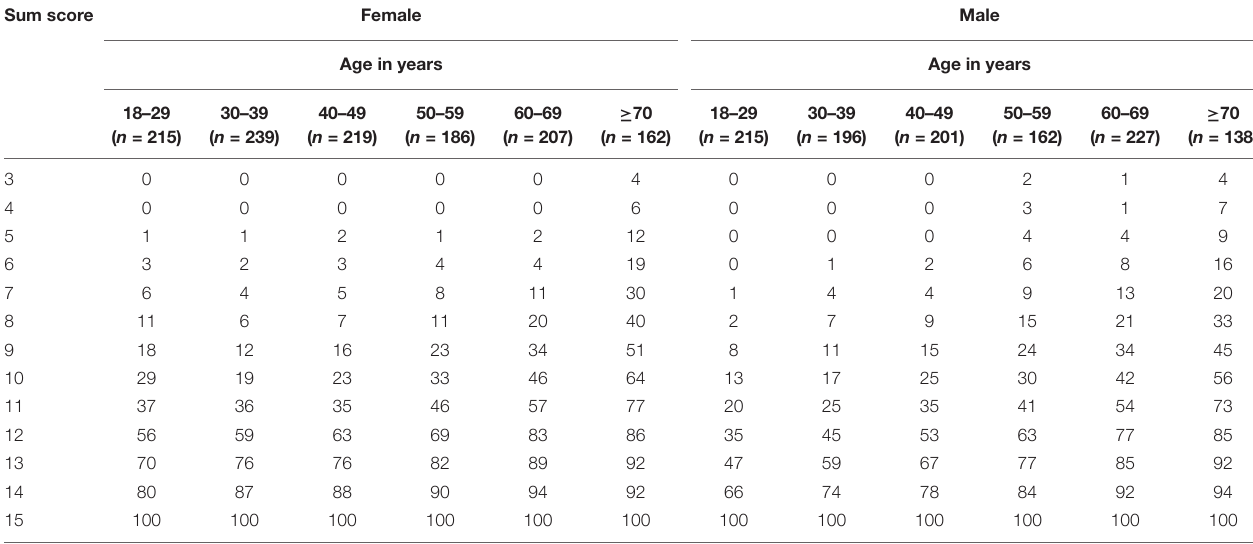
TABLE 7b | Normative percentile ranks for the VBD ideal.